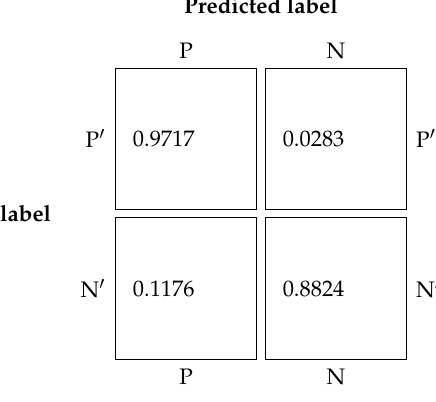
Figure 6. Standardized Confusion